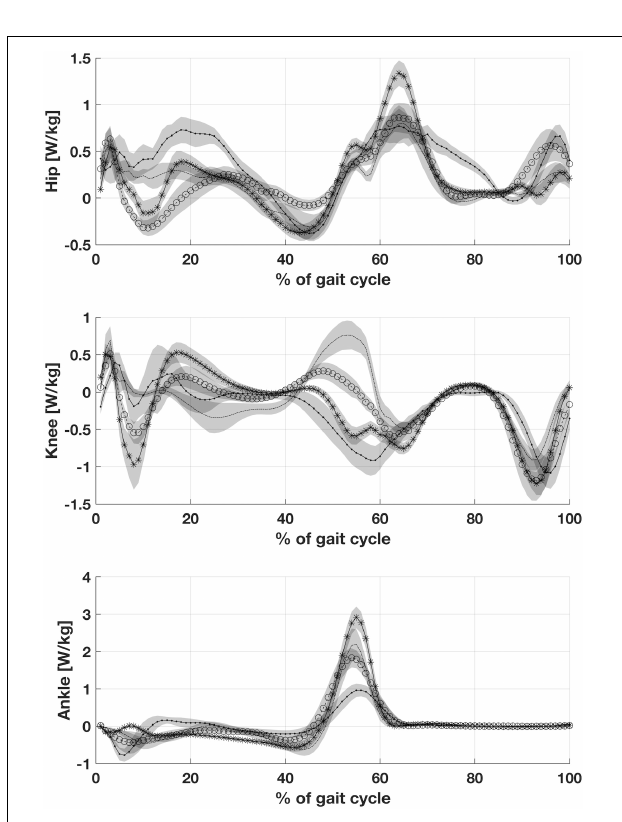
FIGURE 4 | Depicts joints power: Hip joint power, Knee joint power and Ankle joint power. CP, participants with Cerebral Palsy; CMT, participants